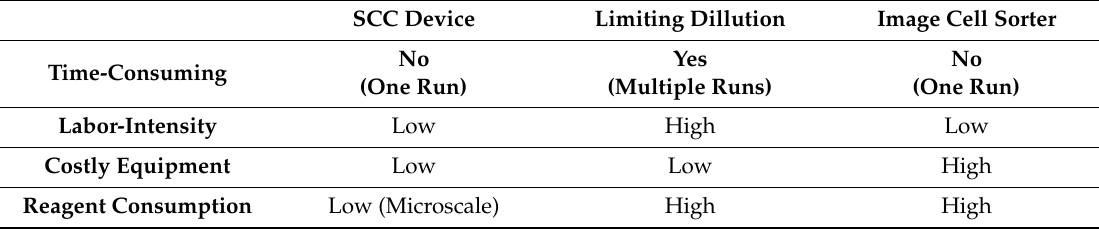
Table 2. Comparison of SCC device, limiting dilution, and image cell